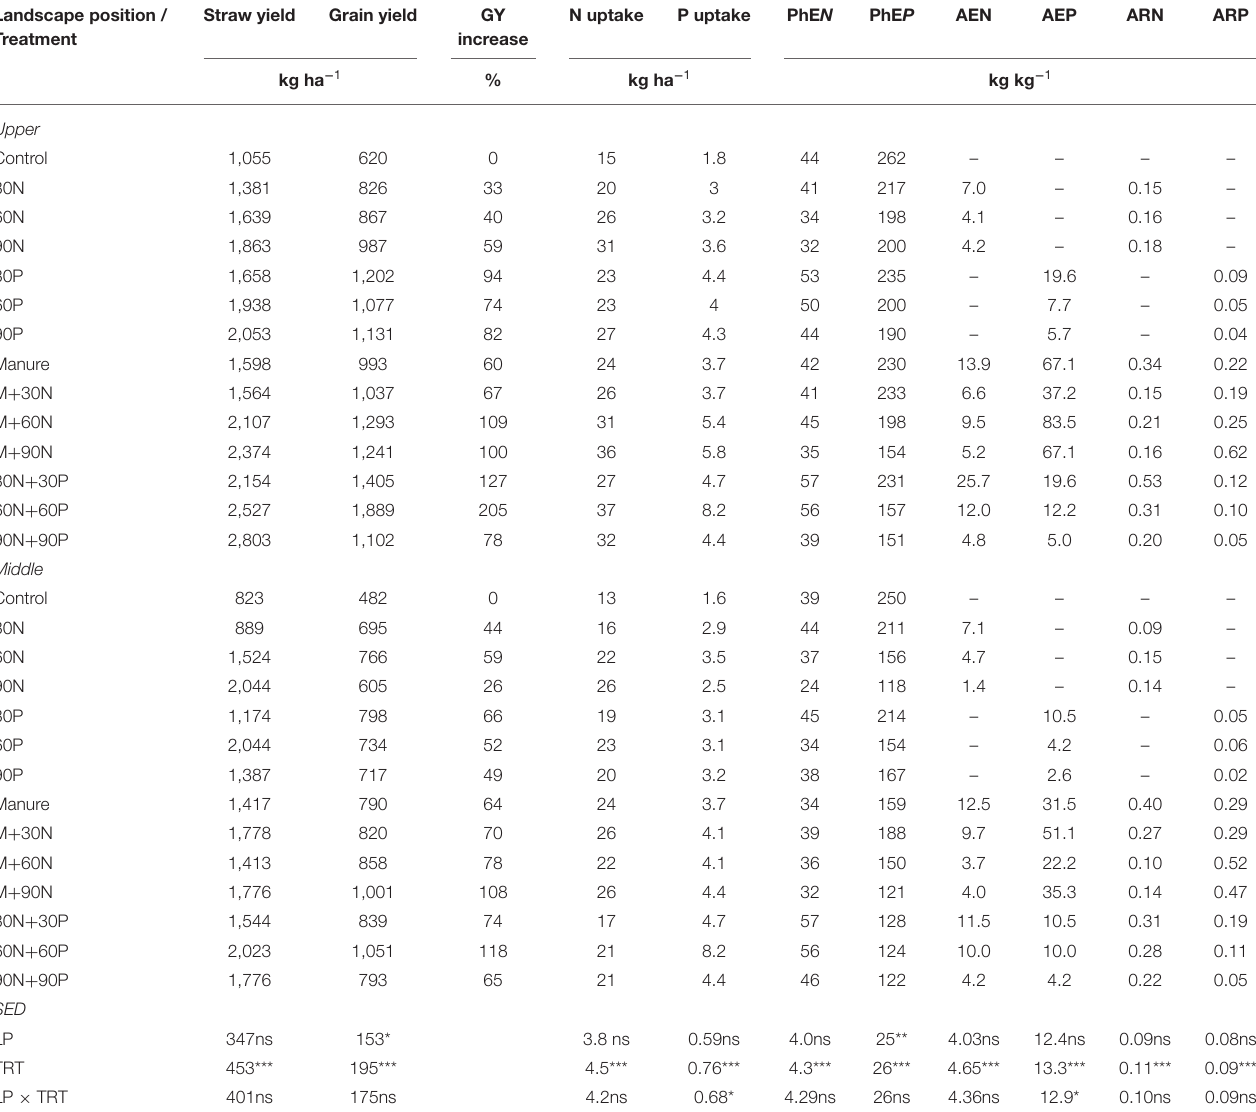
TABLE 4 | Average straw yield, grain yield, total nutrient uptake and internal nutrient use efficiencies, agronomic efficiencies, and recovery efficiencies of finger millet as affected by application of nutrient inputs to degraded fields on the upper and middle landscape positions in Onamudian village, 2 seasons of 2006. Landscape position /